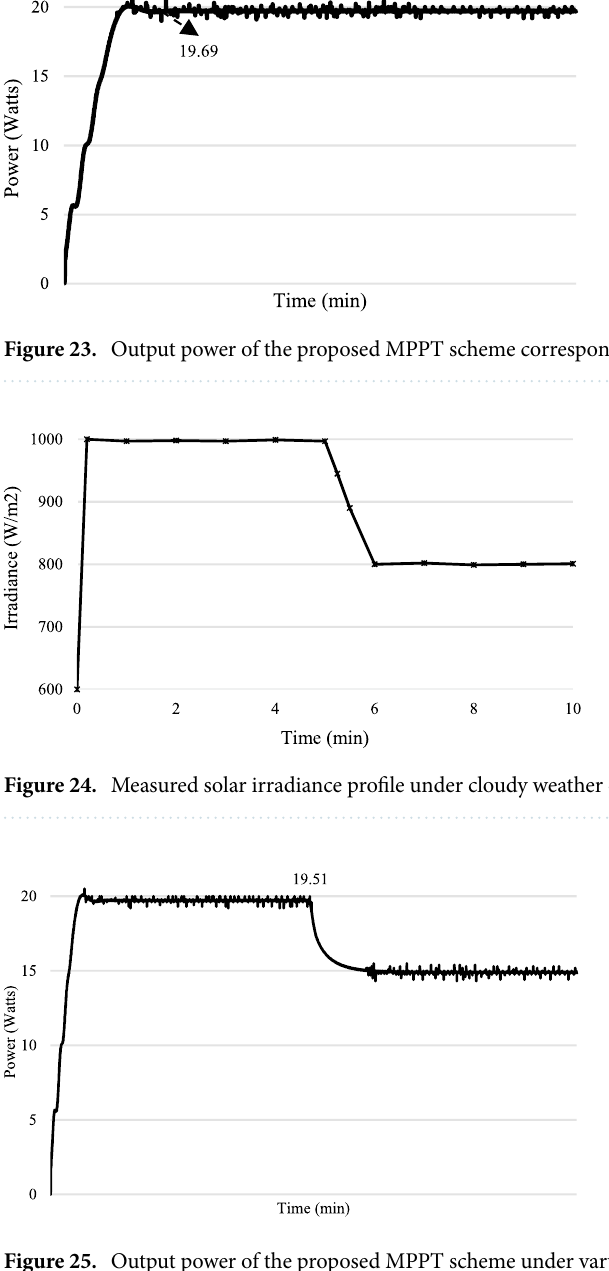
Figure 25. Output power of the proposed MPPT scheme under varying solar insolation.